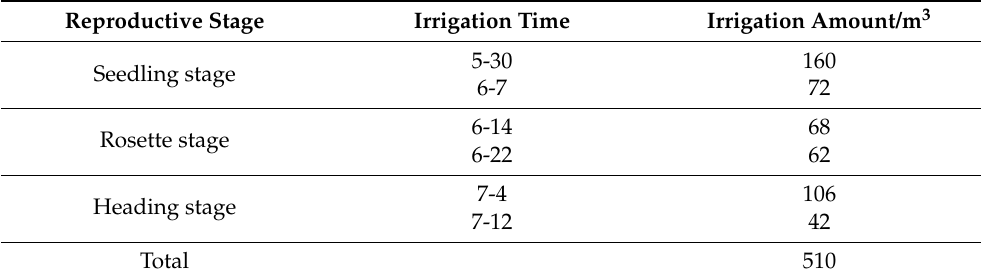
Table 2. Irrigation time and irrigation amount of